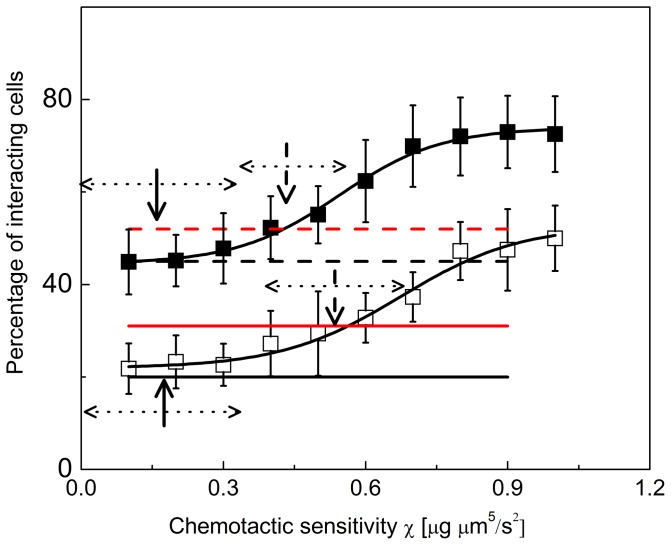
Dependence of the duration times of the NK – dendritic cell interaction on the chemotactic parameter.Percentage of the interacting cells computed on a set of 10 independent simulation runs. The percentage of all the interacting cells (filled squares) and of the long interacting cells (open squares; interaction duration larger than Tth = 600s) are reported. The lines are the sigmoidal fits to the data (y = 74–33.5/(1+ exp ((χ−0.54)/0.108)), solid line; y = 53–31/(1+ exp ((χ−0.674)/0.127)), dashed line). The horizontal lines indicate the experimental percentage of the NK cells interacting with dendritic cells: total number of interactions (dashed lines) under no stimulus (black) and under the action of lipopolysaccharide stimulus (red); long duration interactions (Tth  = 600s) (solid lines) under no stimulus (black) and under the action of lipopolysaccharide stimulus (red). The vertical arrows indicate the most probable values of the chemotactic parameter as visually obtained from the intersection of the interpolating sigmoidal curves and the horizontal lines. The horizontal dotted arrows indicate the range of variability of the chemotactic parameter. The experimental data were obtained from experiments in ex-vivo lymph nodes from mice not treated with the lipopolysaccharide stimulus (black horizontal lines) and from mice treated with the lipopolysaccharide stimulus 4 hours in advance (red horizontal lines; see also Materials and Methods).